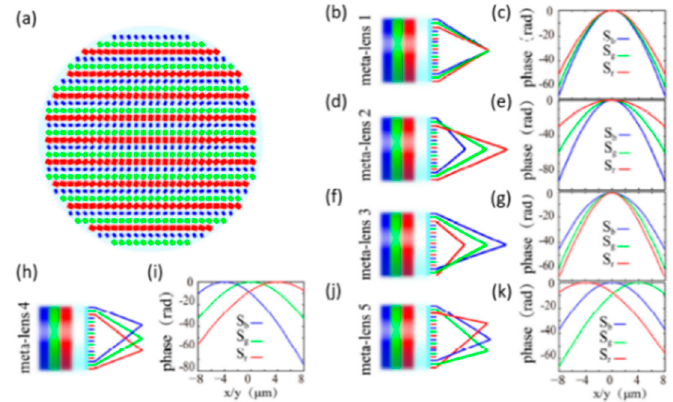
Figure 7. Dispersion controlling meta-lens. ( a ) The schematic of the designed metasurface. ( b ) Schematic and ( c ) phase distribution of achromatic metalens M1. ( d ) Schematic and ( e ) phase distribution of super-dispersion metalens M2 designed to separate different wavelength light in order of normal dispersion. ( f ) Schematic and ( g ) phase distribution of super-dispersion flat metalens M3 with anomalous dispersion. The distribution of focal points is opposite to M3. ( h ) Schematic and ( i ) phase distribution of super-dispersion flat metalens M4 with off-axis color separation. ( j ) Schematic and ( k ) phase distribution of super-dispersion flat metalens M5 with different off-axis colors separation. (Reproduced from [38] with permission).